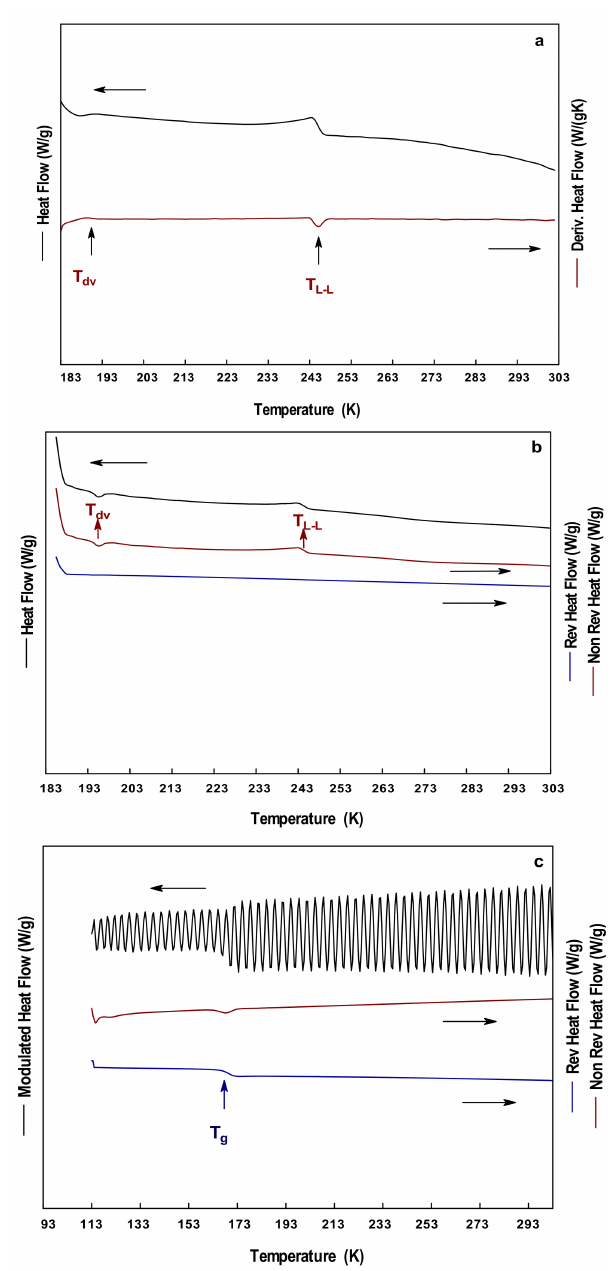
Figure 5. Thermograms of PG at 278 K/min: ( a ) DSC; ( b ) MDSC; and ( c )